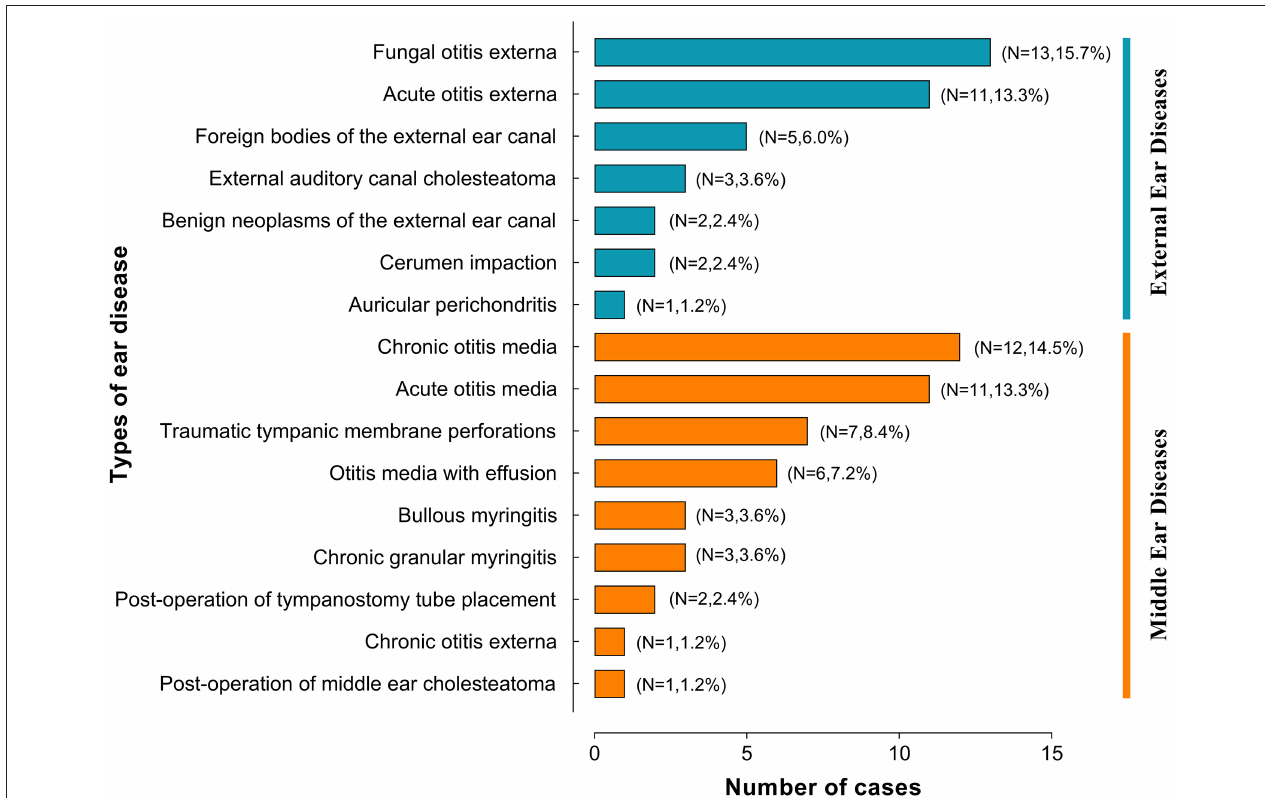
FIGURE 2 | Types of ear disease in patients enrolled in a smartphone otoscope telemedicine study within a rural medical